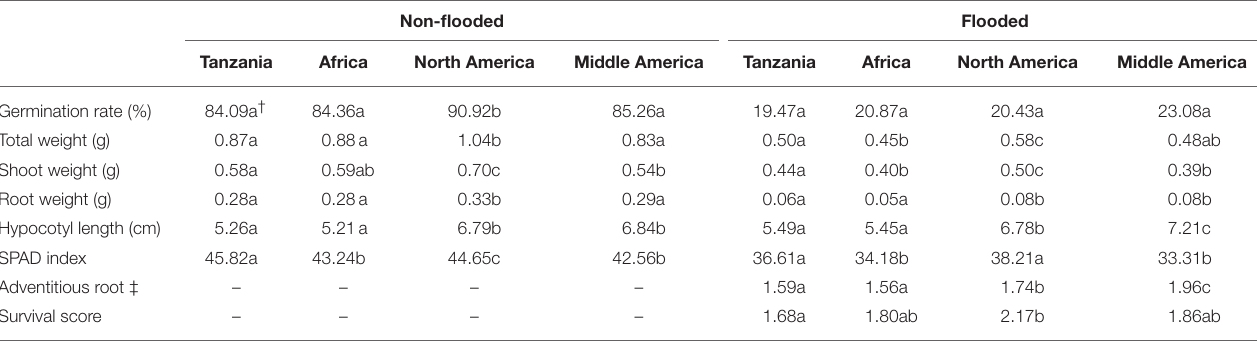
TABLE 2 | Trait means for the four major subpopulations.